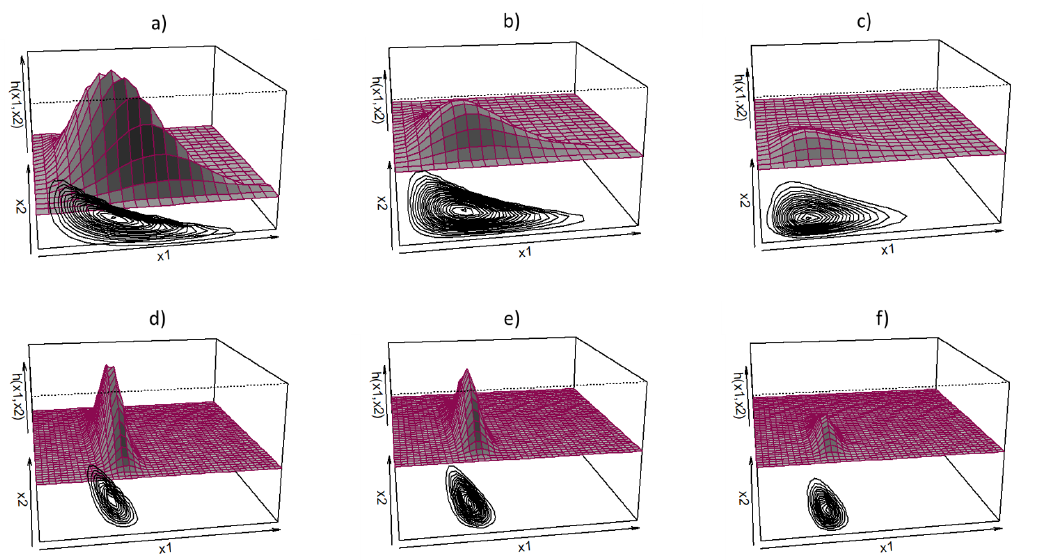
Figure 4. Example pdfs and contour plots of ( 10 ) for various values of ( α 1 , α 2 , α 3 , δ 1 , θ 1 , δ 2 , θ 2 , λ ) when ( a ) (2,2,2,2,2,2,2, − 4), ( b ) (2,2,2,2,2,2,2,0), ( c ) (2,2,2,2,2,2,2,4), ( d ) (4,2,8,12,8,2,0.5, − 8), ( e ) (4,2,8,12,8,2,0.5, − 4), ( f )